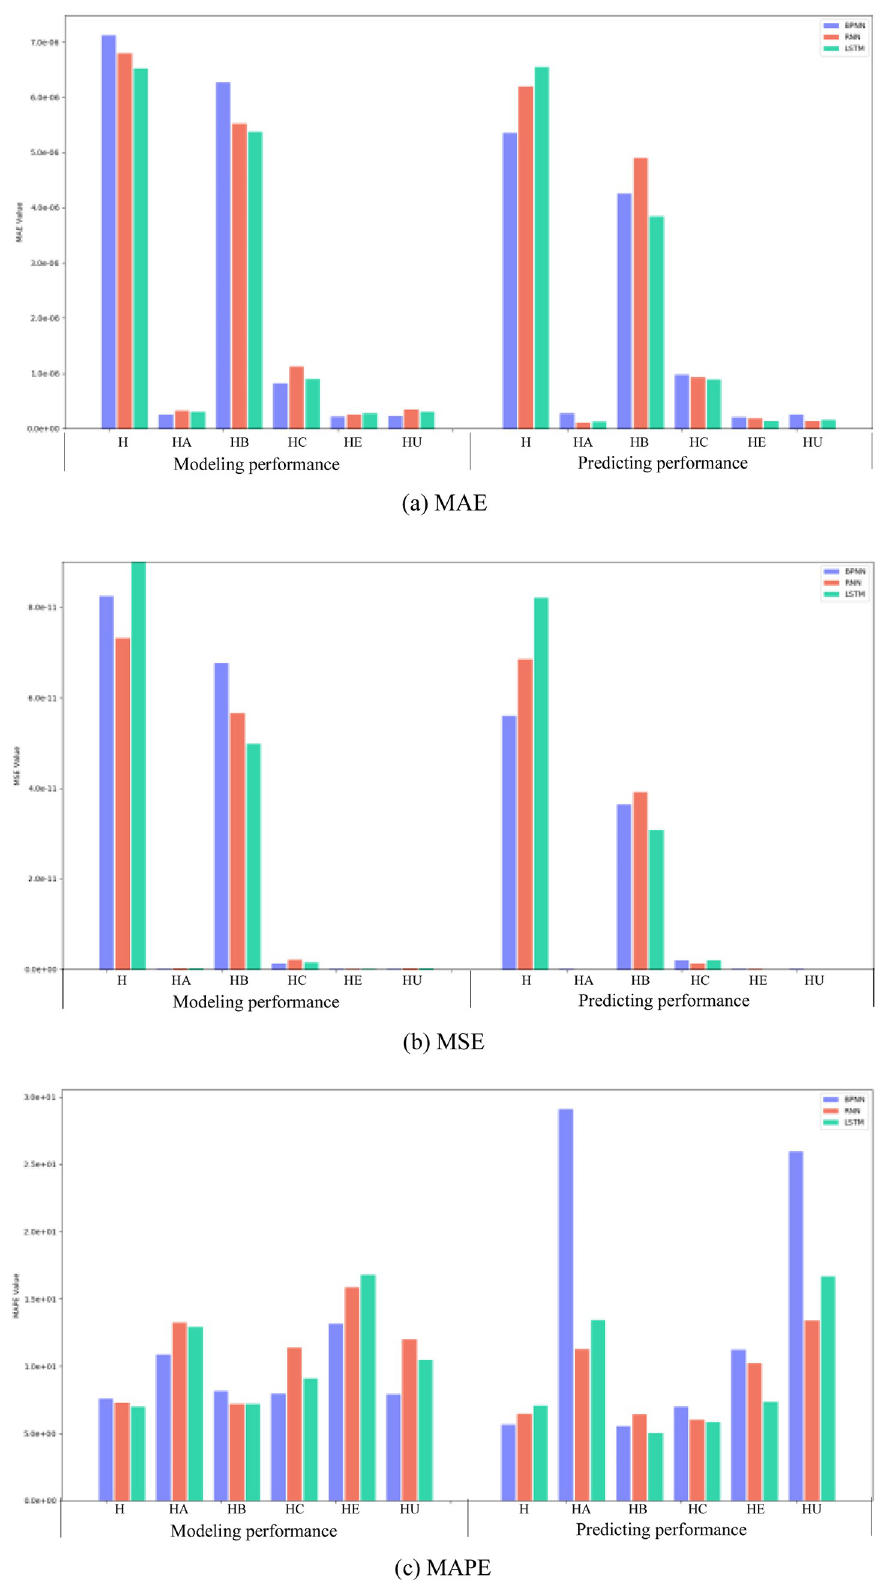
Fig 5. Prediction performance of the three neural network models. (a) MAE, (b) MSE, (c) MAPE. https://doi.org/10.1371/journal.pone.0265660.g005 PLOS ONE | https://doi.org/10.1371/journal.pone.0265660 April 13,